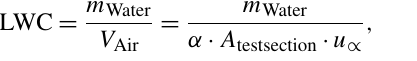
Instrument measurement